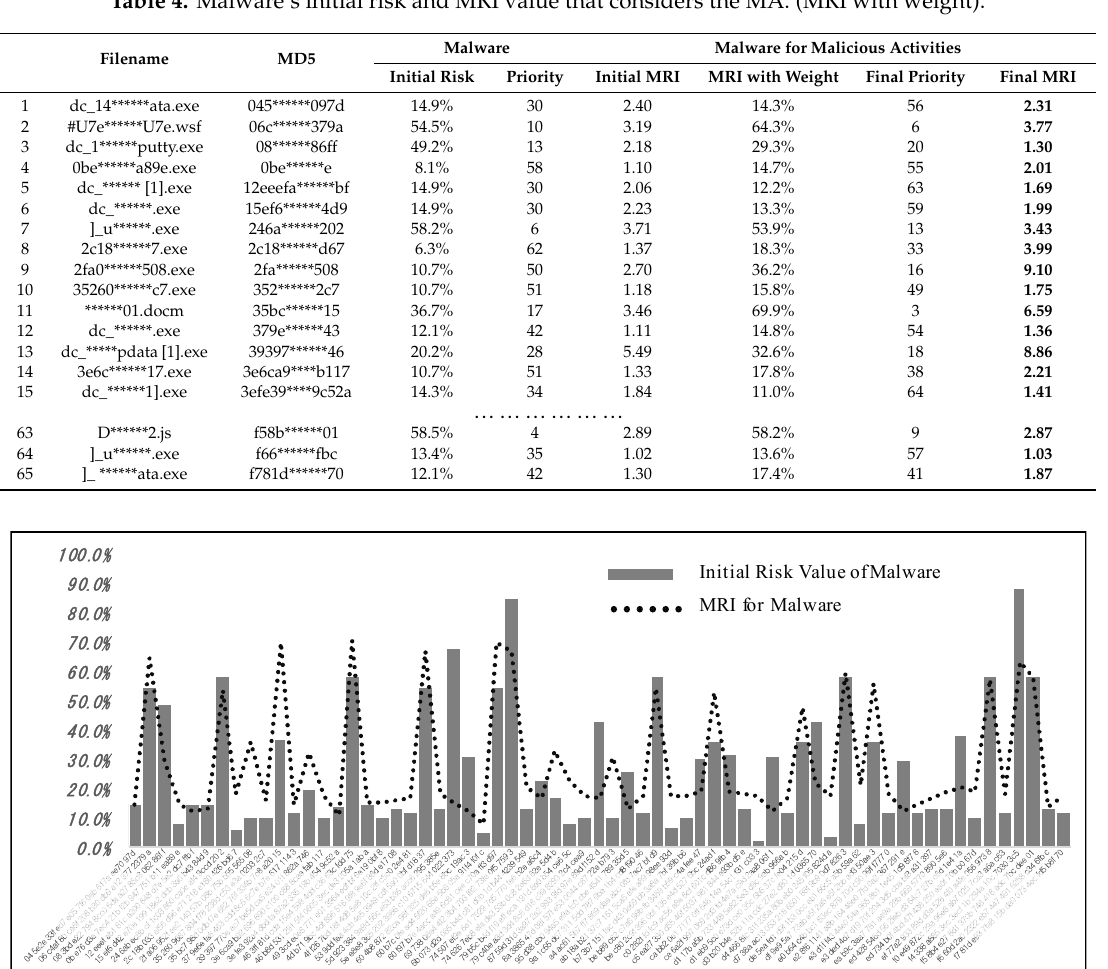
Figure 3. Difference between initial risk value and the final MRI value for a certain time window. Figure 3. Di ff erence between initial risk value and the final MRI value for a certain time